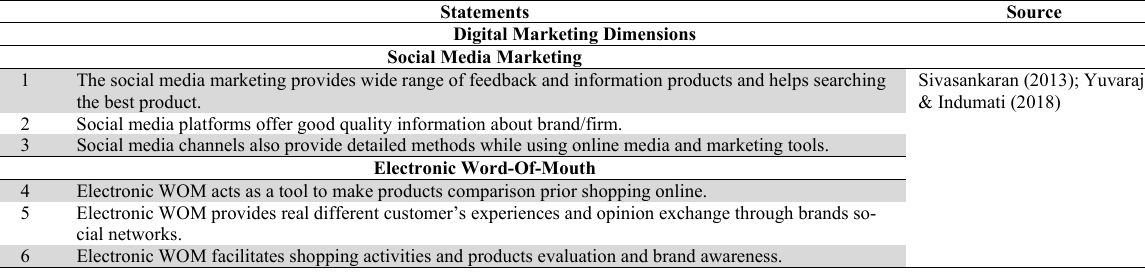
Research Instrument